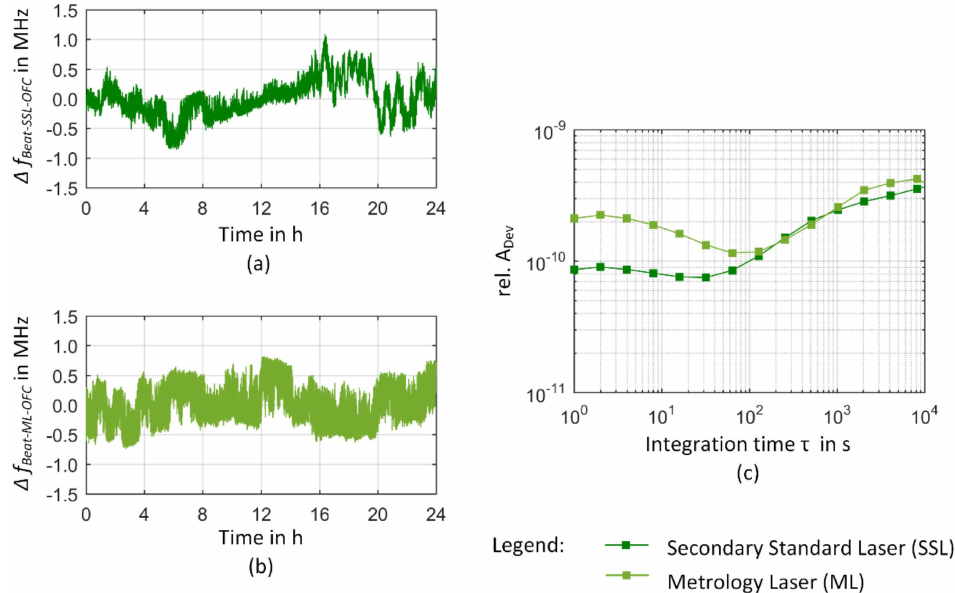
Figure 10. Frequency instability of the He-Ne heterodyne source used as a starting point for the realization of a comb-referenced laser module. ( a ) A 24 h-measurement series of the secondary standard laser (SSL) against a comb line, ( b ) 24 h measurement of the metrology laser (ML). In each of the plots, the frequency deviations from the mean value derived over the whole measurement series of 24 h are shown. ( c ) Relative Allan deviations obtained by dividing the frequency fluctuations by a nominal value of 474